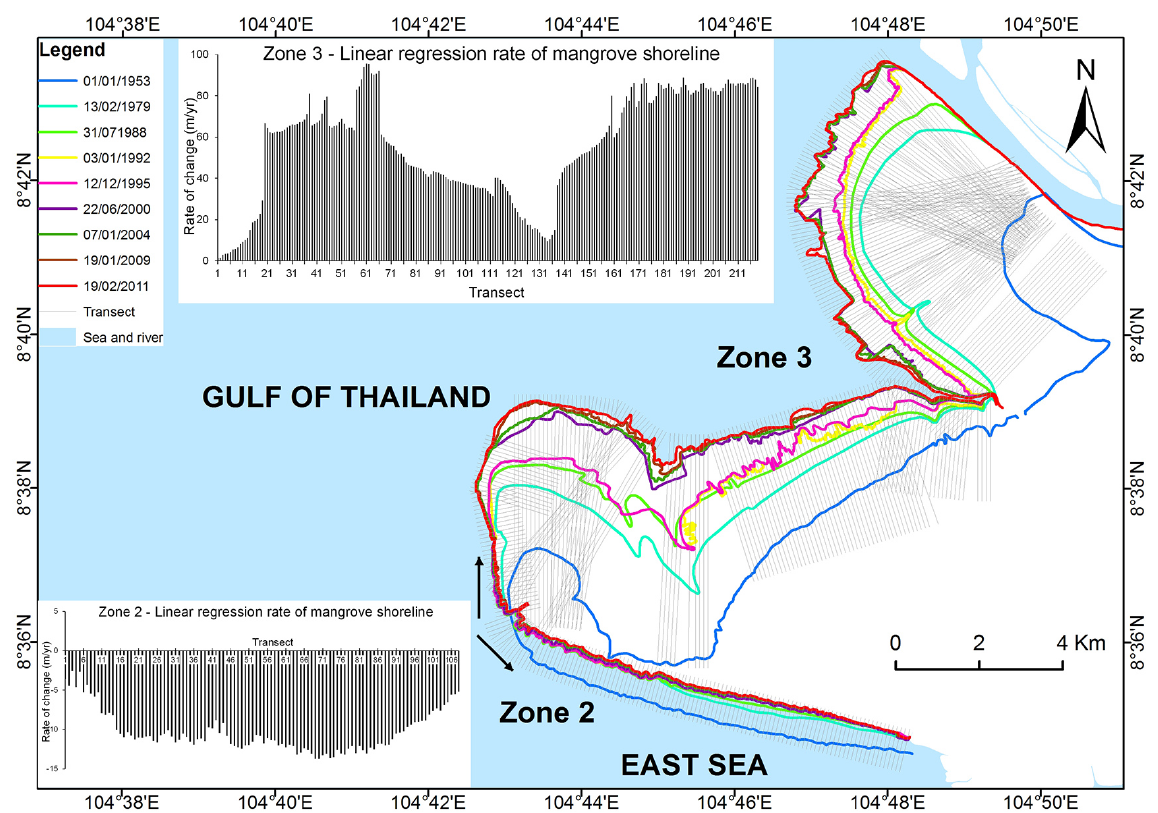
Figure 3. Mangrove shoreline change in zones 2 and 3. Zone 2 is located on the East Sea coast and zone 3 on the Gulf of Thailand. DSAS software generated 108 and 219 transects for zones 2 and 3, respectively. The arrow shows the direction of transects from 1 to 108 for zone 2 and from 1 to 219 for zone